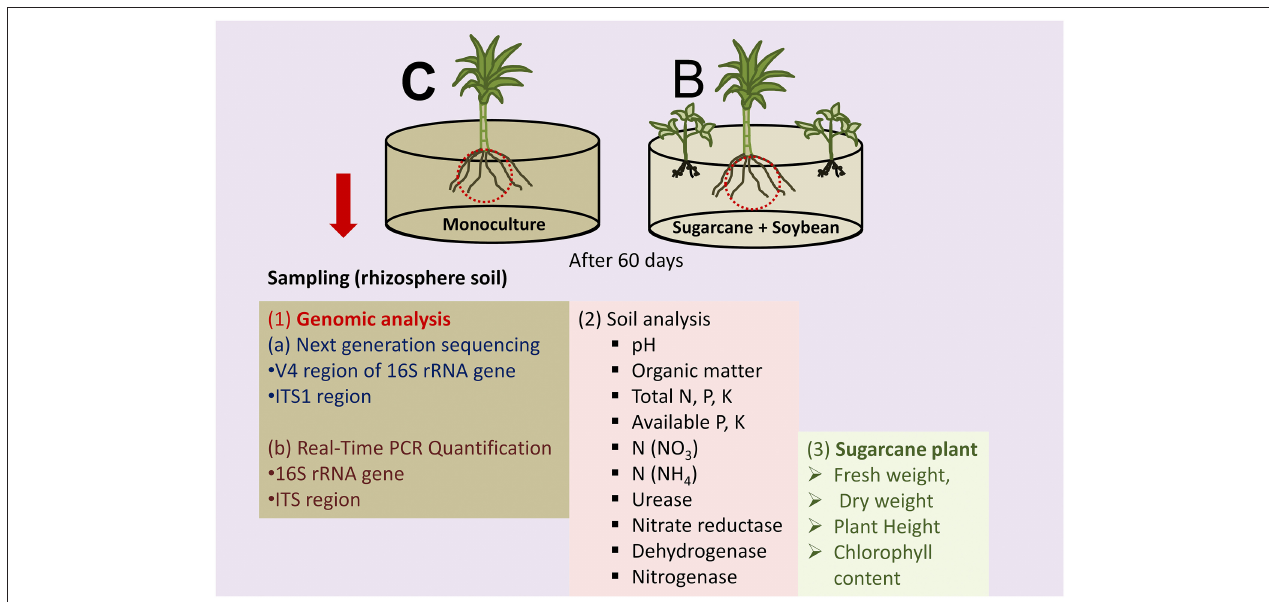
FIGURE 1 | Schematic diagram of experimental design and analysis.